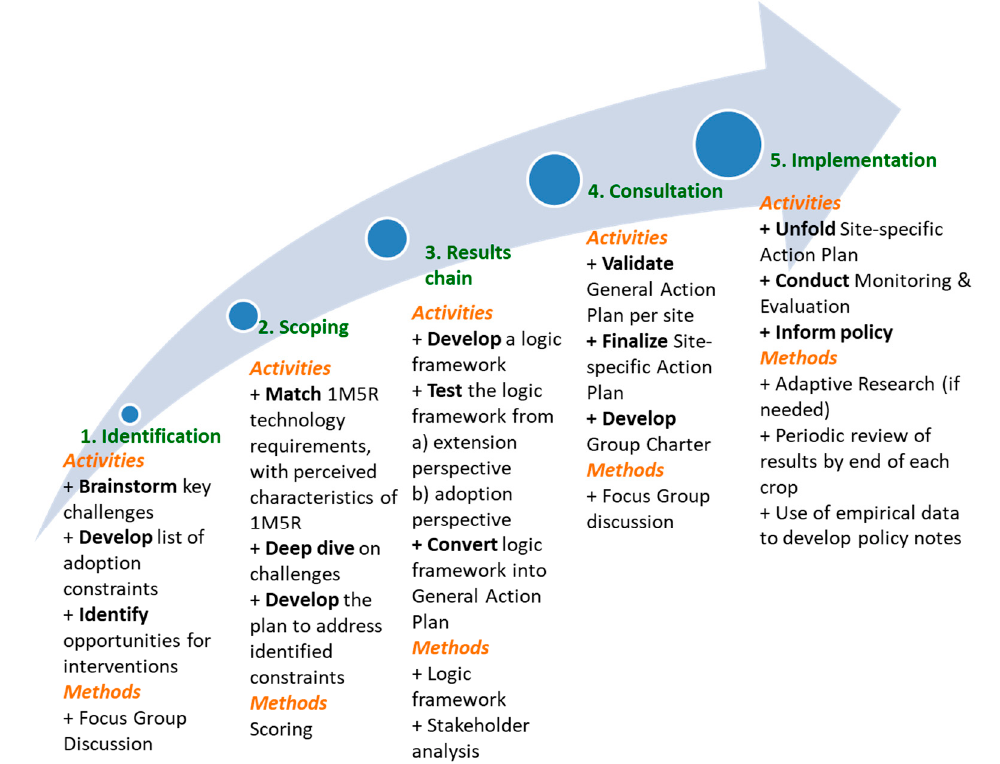
Figure 4. Five steps of the Adult Learning Process under Vietnam Sustainable Agricultural Transformation project (VnSAT) with the activities and methods for each. Adapted from Tuan and Singleton [39].